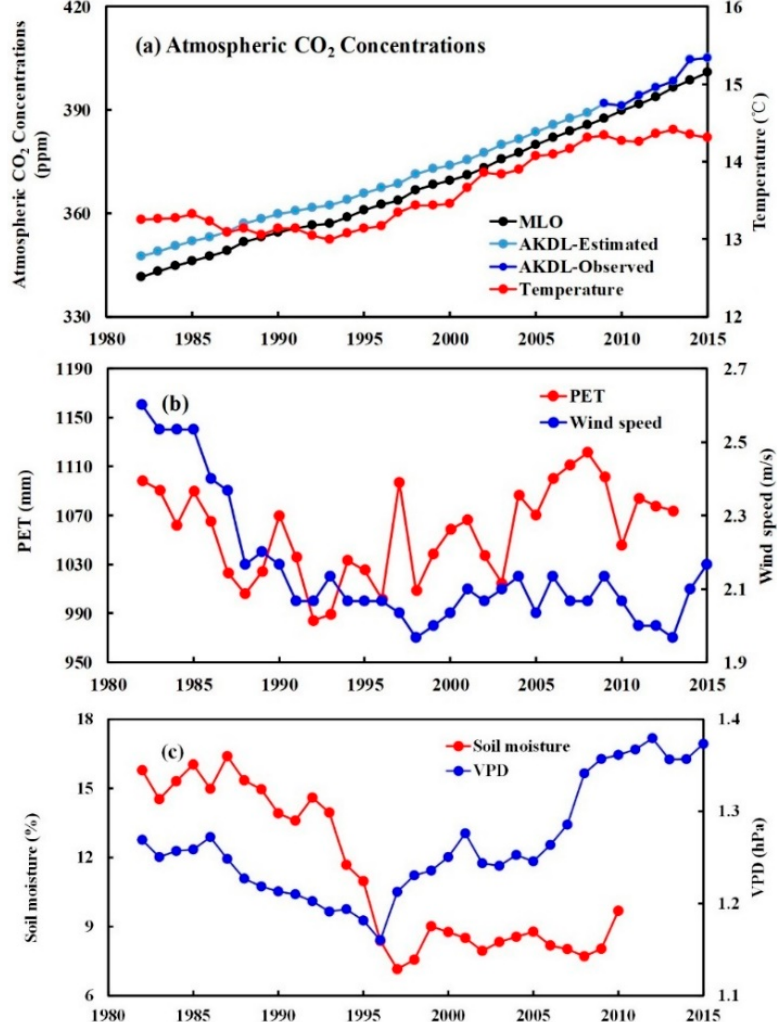
Figure 15. The long-term changes in atmospheric CO 2 concentrations and other climatic variables over the GS in Xinjiang from 1982 to 2015. ( a ) Atmospheric CO 2 concentrations at the Mauna Loa Observatory (MLO) and Akedala Observatory (AKDL), and air temperature; ( b ) PET (modified according to Yao et al. [38]) and wind speed; ( c ) soil moisture (modified according to Yao et al. [37]) and VPD,